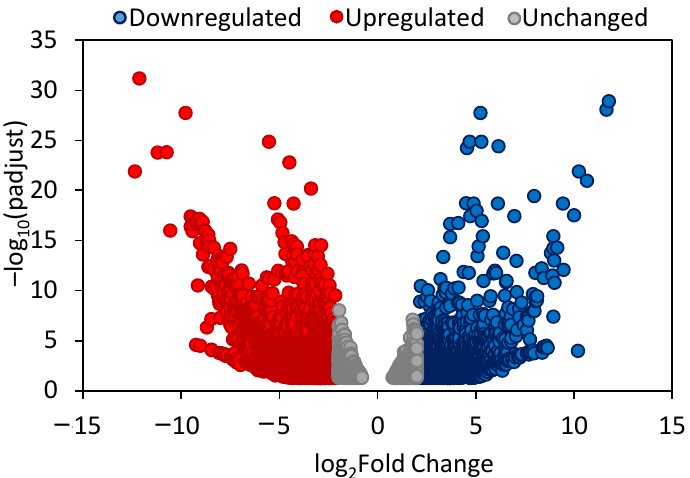
Figure 1. Identified differentially expressed gene clusters (DEGs) between P. zonale GL and WL. Volcano plots showing the expression level of each unigene. Limits defined by p -value ≤ 0.05 and abs (log2 fold change) ≥ 2. Red dots represent up-regulated genes in WL, blue dots represent down-regulated genes in WL, and grey dots represent statistically unchanged